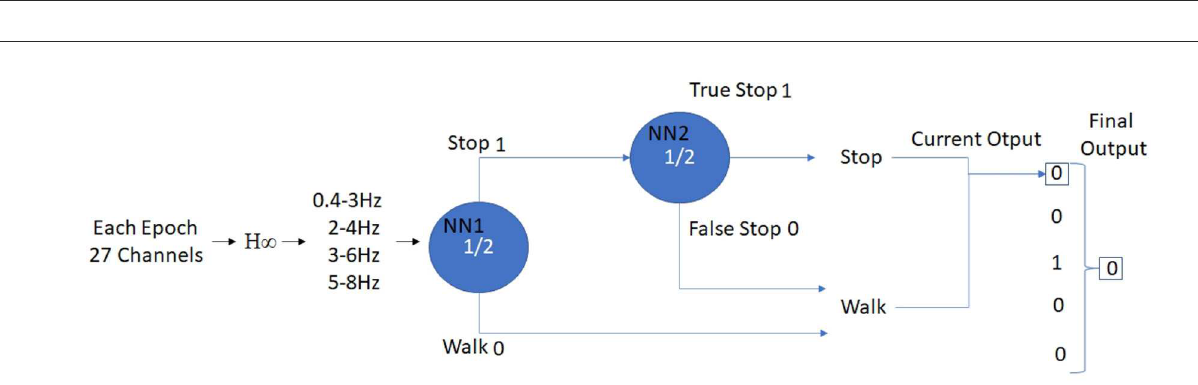
FIGURE5 The prediction for the combination of NN1 and NN2 using pseudo-online (without output command) and online (with output command) is done as follows: each epoch is preprocessed with the described filtering stages, and each channel and filter is concatenated for input to the first network. This network can classify the epoch as walk or stop, that is 0 or 1. If it’s a 0, it stops at the current output, but if it is a 1, the second classifier will check if it considers it a False Stop or a True Stop and in any case this value will pass to the current output. These values are accumulated and the Final Output is the mode of the last five